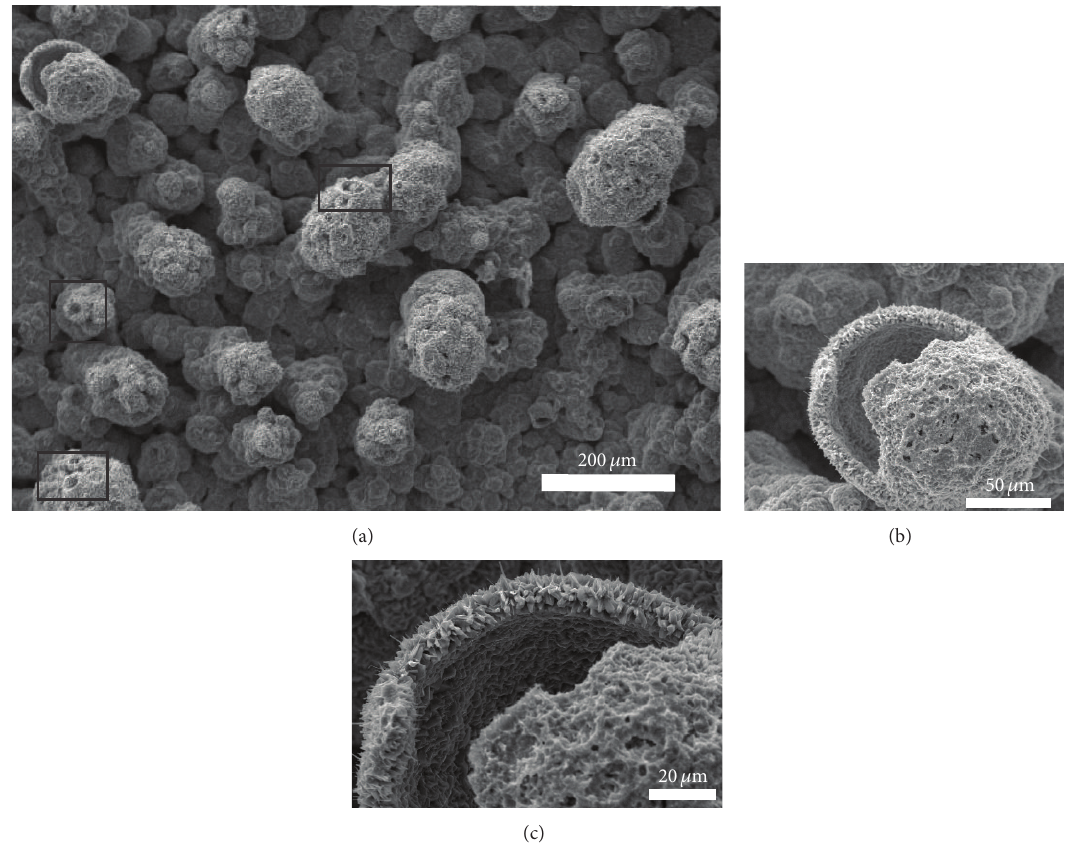
Figure 4: SEM images of ZnO microclusters: (a) low magnification, (b) individual ZnO microcluster, and (c) high magnification of the ZnO